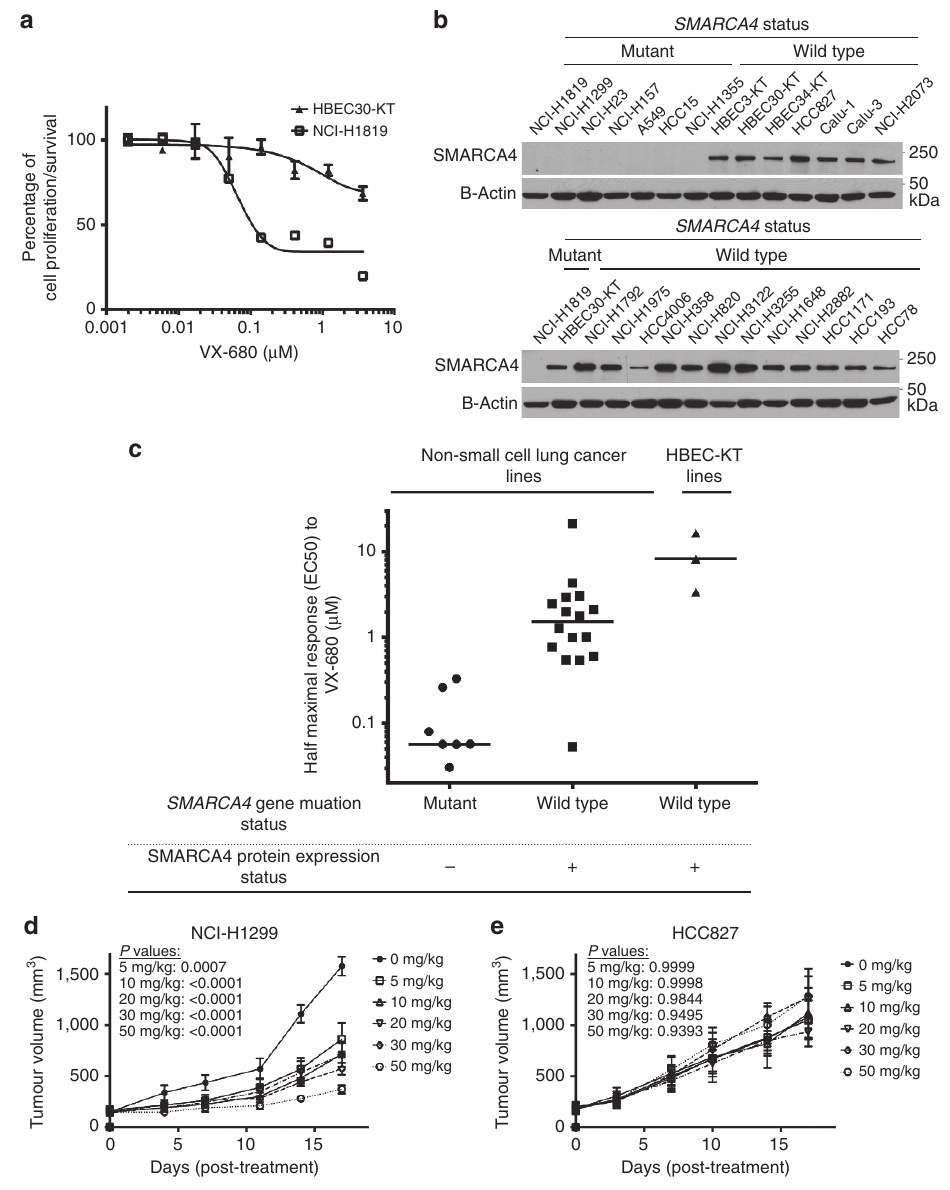
Figure 4 | Preferential cytotoxicity of SMARCA4 -mutant cells after treatment with AURKA inhibitor VX-680. ( a ) NCI-H1819 and immortalized bronchial epithelial cell line HBEC30-KTwere treated with serial concentrations of VX-680 and cell viability was measured with a CellTiter-Glo assay. Data are means of triplicate biological replicates with s.d. Some error bars are smaller than the data symbols. ( b ) Cell lysates of 26 NSCLC and HBEC lines were collected and immunoblotted to monitor SMARCA4 levels. SMARCA4-null NCI-H1819 and SMARCA4-wild-type HBEC30-KT were used in both sets of immunoblots as controls. ( c ) A panel of NSCLC and HBEC lines was treated with VX-680 in duplicate, independent dose–response experiments and the mean EC50s of their individual responses are shown. Horizontal bars indicate medians of sample groups. ( d ) SMARCA4-null NCI-H1299 cells and ( e ) SMARCA4-wild-type HCC827 cells were xenografted on NOD/SCID mice. VX-680 treatments were performed i.p. twice daily. For each dosage group ( n ¼ 4), the tumour volume mean and s.e.m. are represented by horizontal line. The significance of the difference between the mean of 0mgkg (cid:2) 1 and of each dose regimen on day 17 was calculated by one-way ANOVA and post hoc Dunnett’s multiple comparison tests.